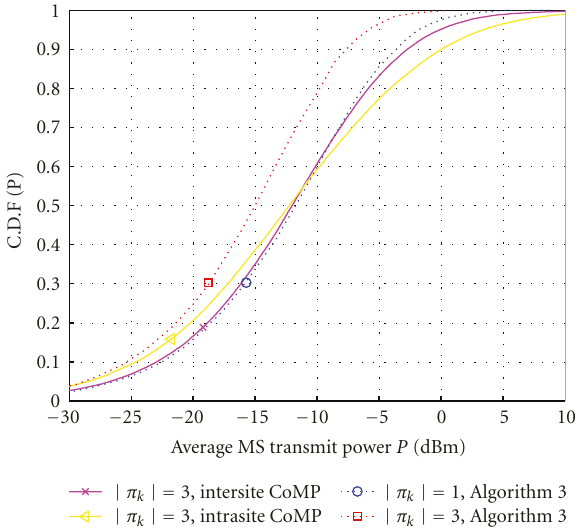
Figure 9: Comparison of CDFs of transmit power of inter-site, intra-site and adaptive reception schemes with the SINR constraint of 0dB.